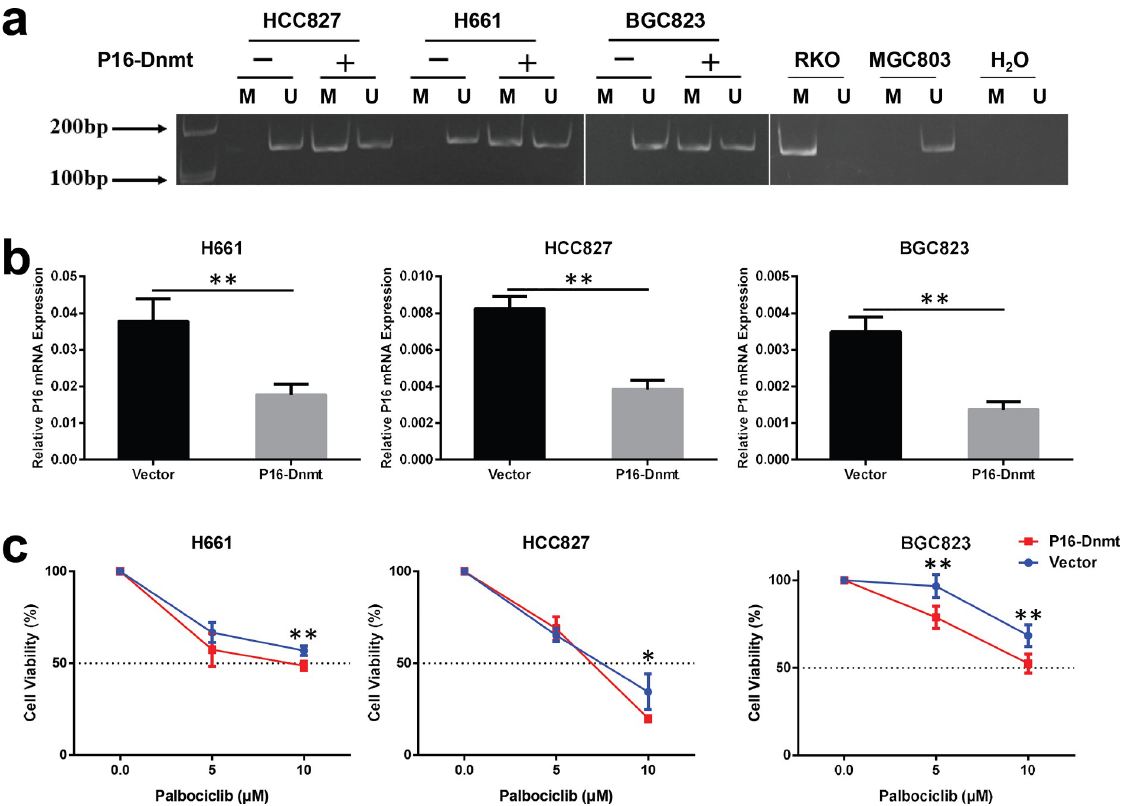
Fig 2. Effect of P16 -specific methylation on the sensitivity of cancer cells to palbociclib. ( a ) Methylation of the CpG P16 island in three cancer cell lines stably transfected with an engineered P16- specific DNA methyltransferase (P16-Dnmt) by MSP. Genomic DNA samples from RKO and MGC803 cells were used as the positive and negative controls for P16 methylation, respectively. ( b ) Effect of P16 -specific methylation on the levels of P16 expression in cell lines stably transfected with P16-Dnmt, as assessed by qRT-PCR. ( c ) Effect of P16 -specific methylation on the viability (survival rate) of cells treated with palbociclib for 48 hrs, as assessed with the IncuCyte ZOOM system. Each point represents the mean ± SD of 4 wells. Student’s t-test, � p < 0.05, �� p < 0.01.